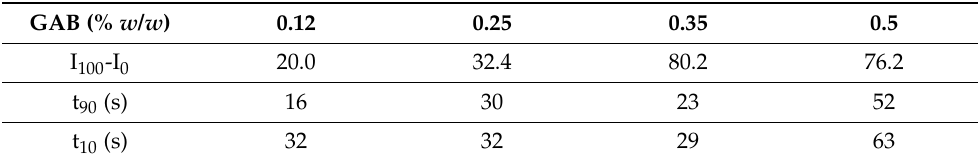
Table 1. Optimization of the amount of GAB versus three variables: I 100 -I 0 parameter, response time and recovery